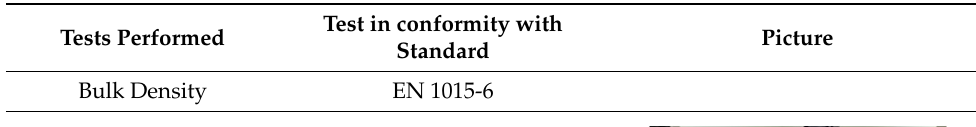
Table 2. Testing procedures adopted in this study.